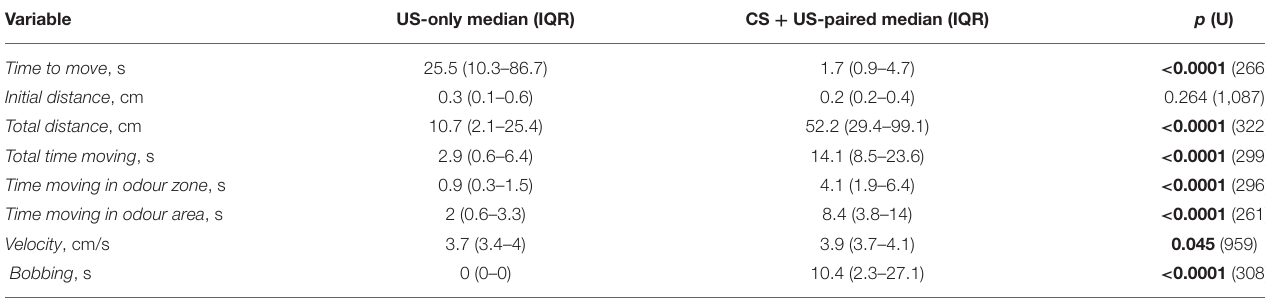
TABLE 1 | Statistical data for response variables.